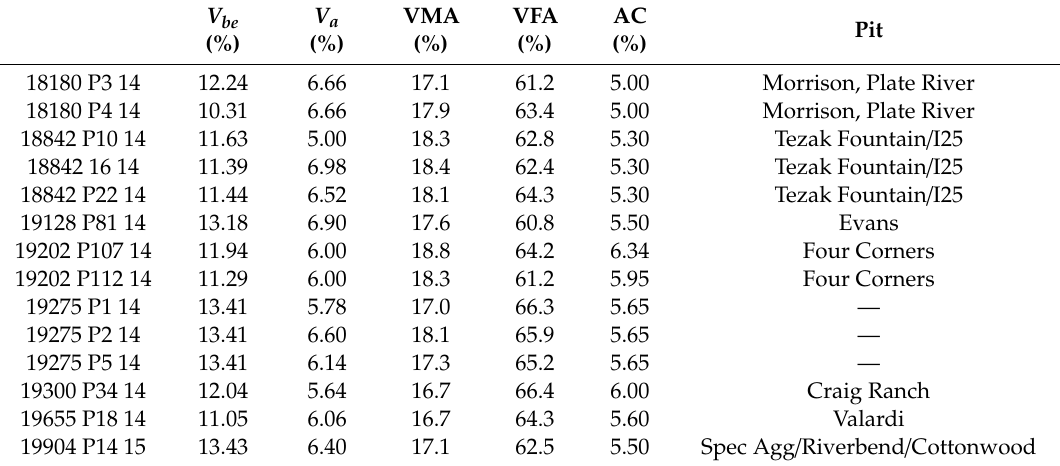
Table 5. Generic information of SX (100) PG 64-22 mix.